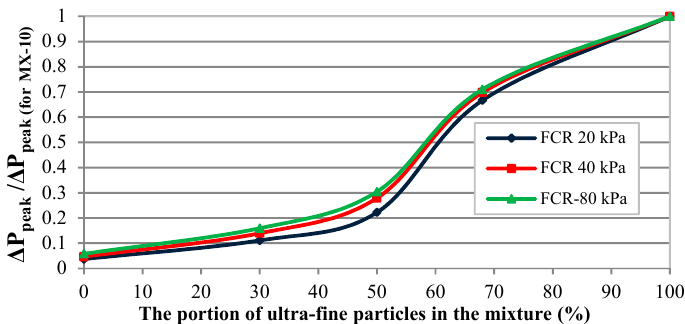
Figure 11. Normalized value of ∆ P peak (using the value of ∆ P peak of ultra-fine particles for each pressure level) for fluidization, compression, and re-fluidization (FCR) tests at 20, 40, and 80 kPa compression pressure.